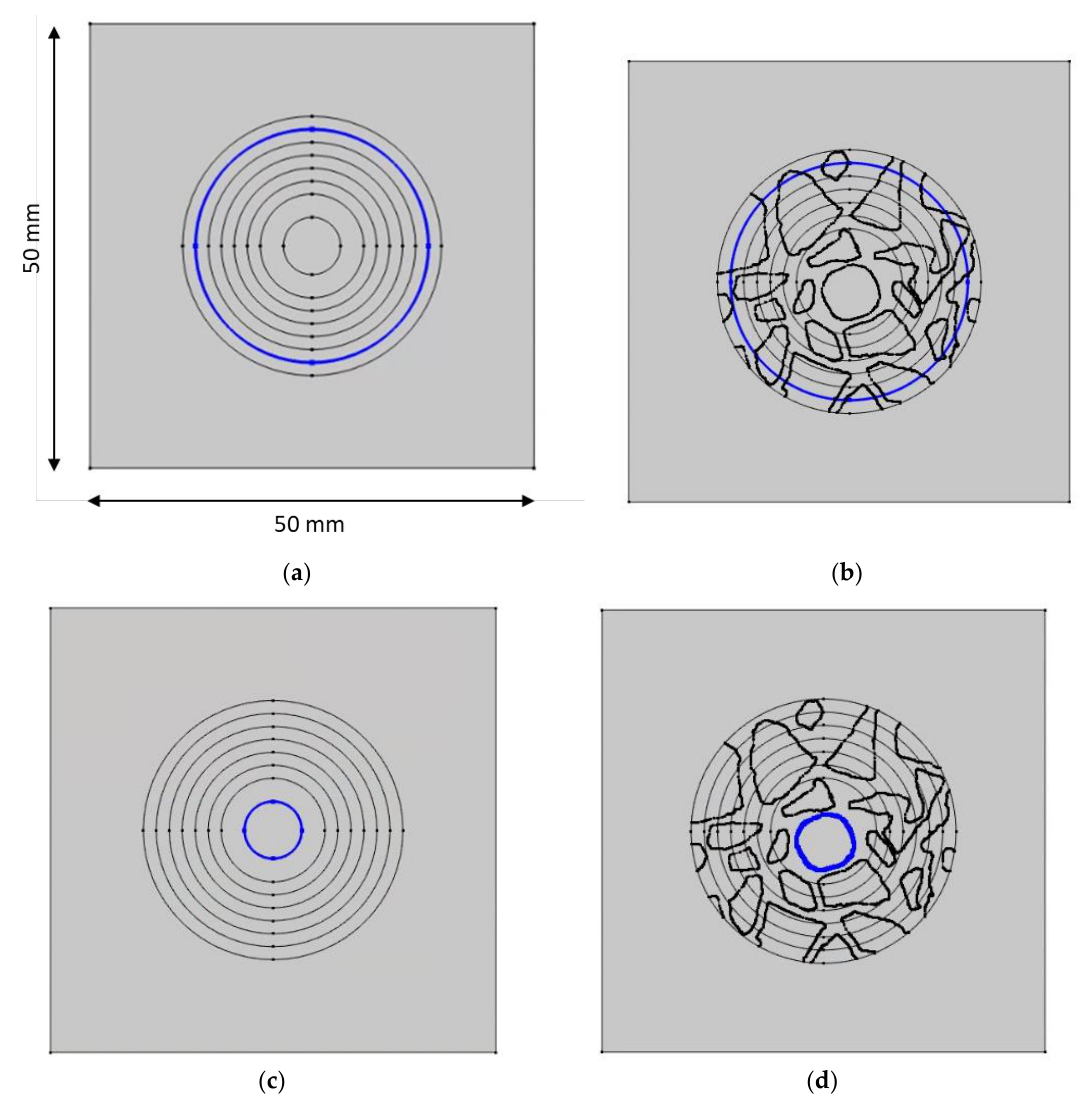
Figure 23. Nonhomogeneous — concrete sample — and homogeneous — mortar sample — with lines (blue) 13 mm from the center and on the surface of the rod. ( a ) mortar sample — 13 mm from the center. ( b ) concrete sample — 13 mm from the center. ( c ) mortar sample — the surface of the rod. ( d ) concrete sample — the surface of the rod.